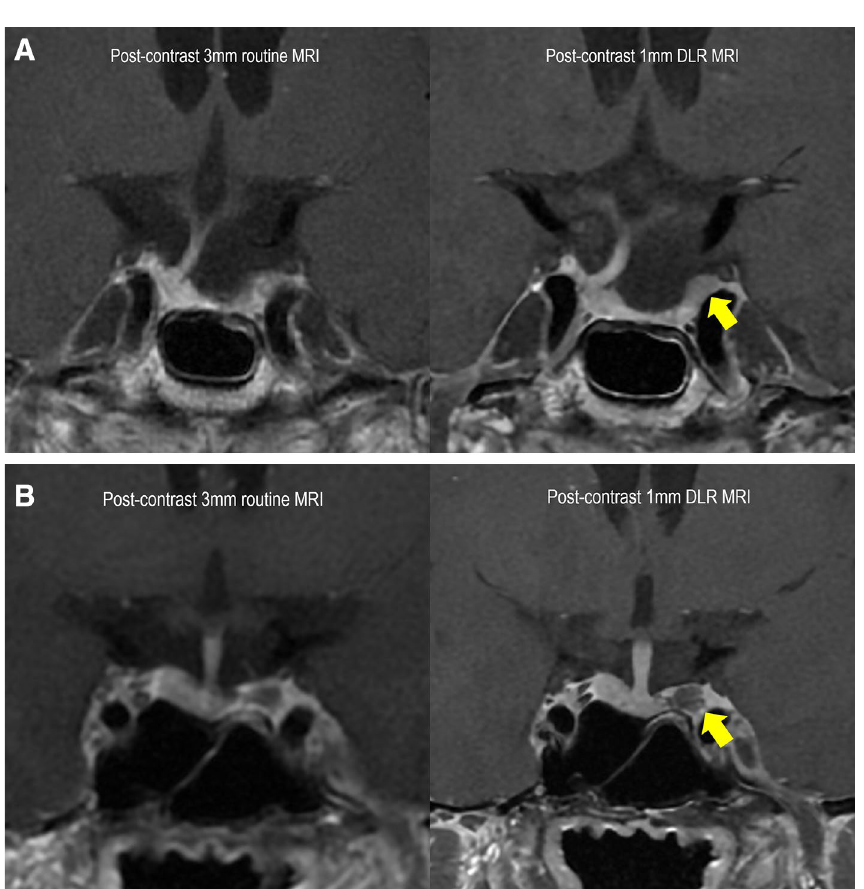
Figure 4. Representative case of improved delineation of pituitary gland and stalk. ( A ) A 65-year-old male patient underwent transsphenoidal resection of non-functioning pituitary adenoma and follow-up MRI 27 months later. The 1 mm DLR shows superiority in the detection of residual tumour delineation of normal pituitary gland and stalk, compared to the 3 mm routine MRI. ( B ) A 43-year-old male patient underwent transsphenoidal resection of prolactinoma and underwent follow-up MRI 41 months later. The 1 mm DLR was superior to 3 mm routine MRI in the detection of residual tumour, as well as in the delineation of normal pituitary gland and stalk. MRI = magnetic resonance imaging, 1 mm DLR = 1 mm slice thickness MRI with deep learning-based